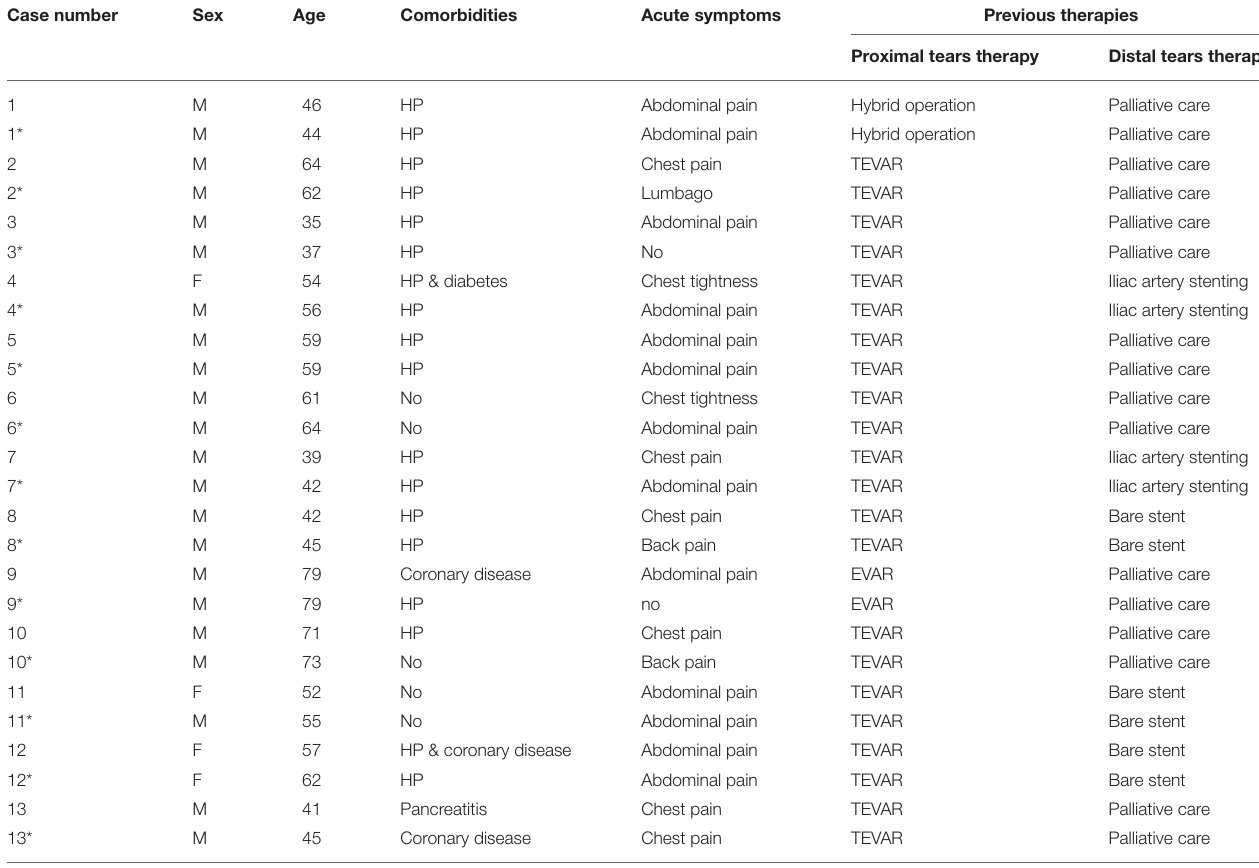
TABLE 1 | Patients’ baseline characteristics. Case number